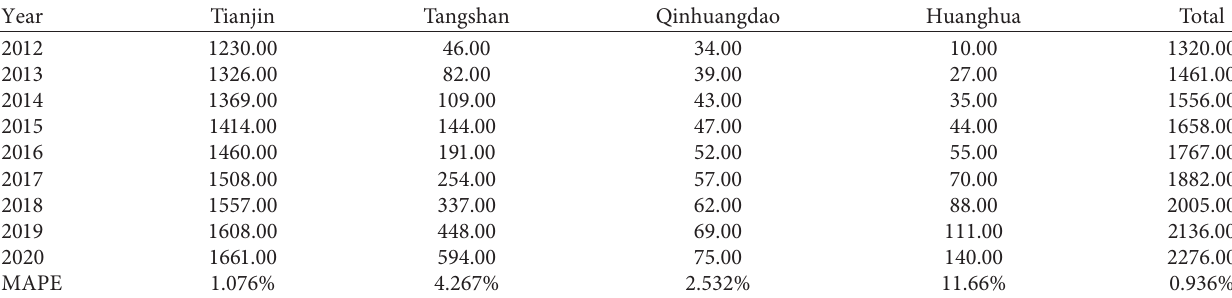
Table 1: GM (1.1) container throughput of Tianjin-Hebei Port Group (unit: 10,000TEU).